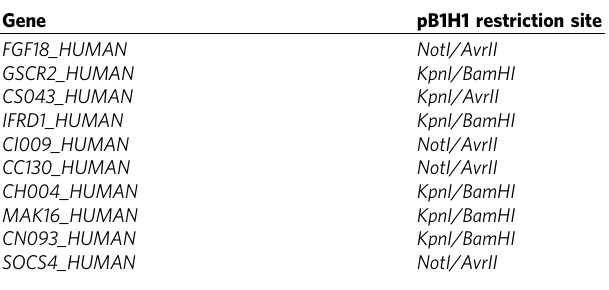
Table 4 | Genes whose ORFs were cloned into the pB1H1 vector and their restriction